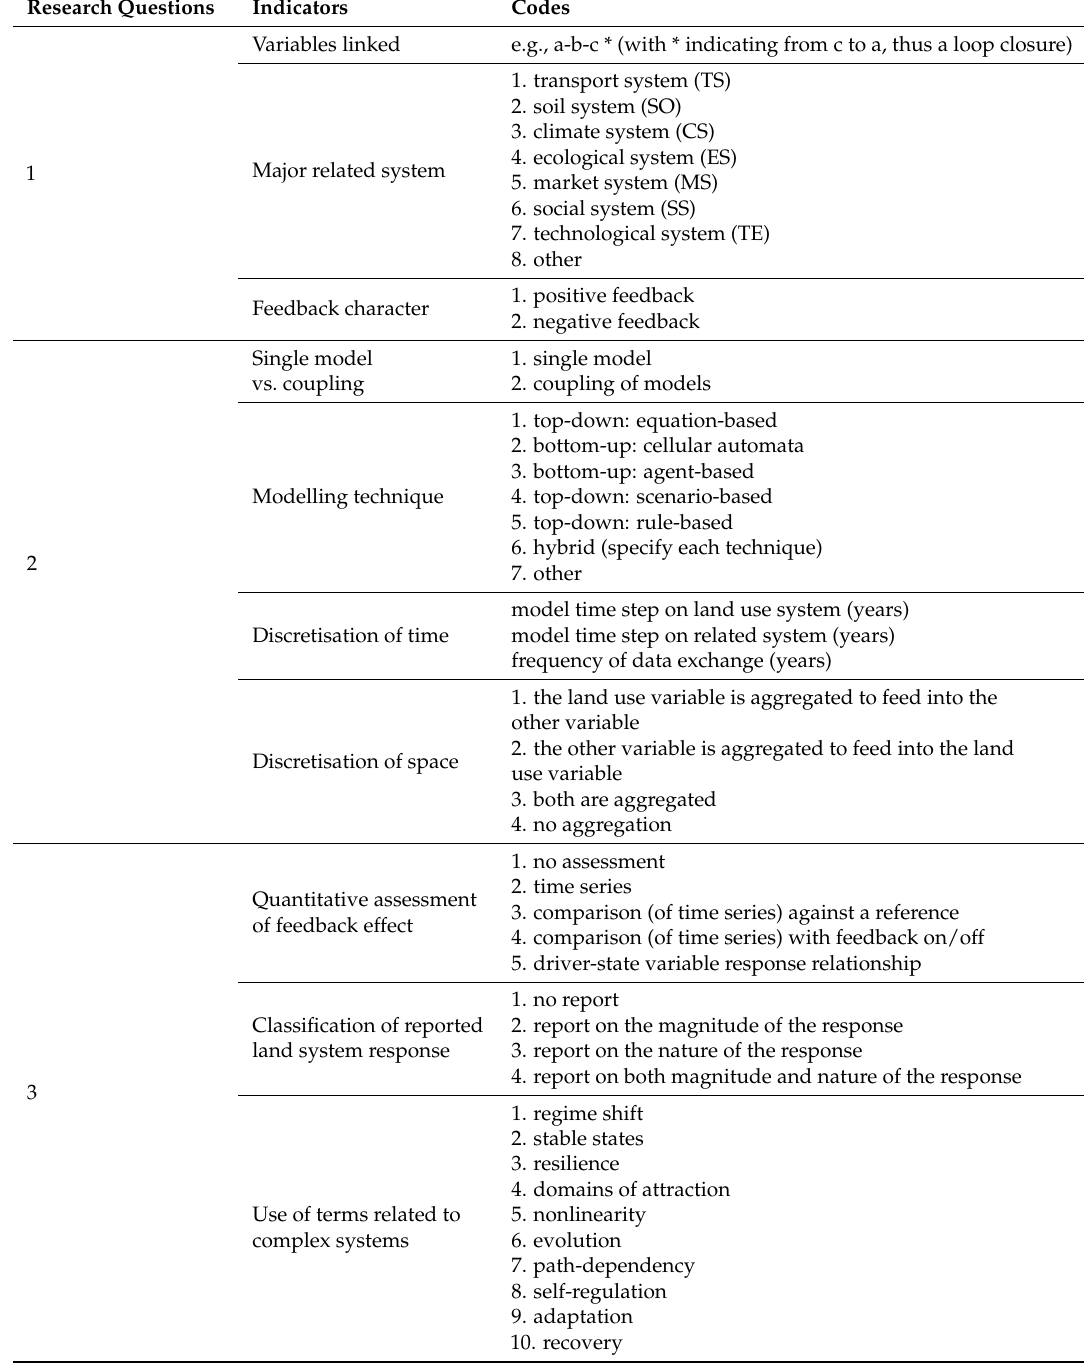
Table 1. Indicators and codes for feedback representations related to the three research questions: (1) What feedback processes within land systems have been modelled? (2) How has feedback representation been achieved in the models? (3) To what extent has the modelling of feedbacks contributed to insights into the complex systems behaviour of land